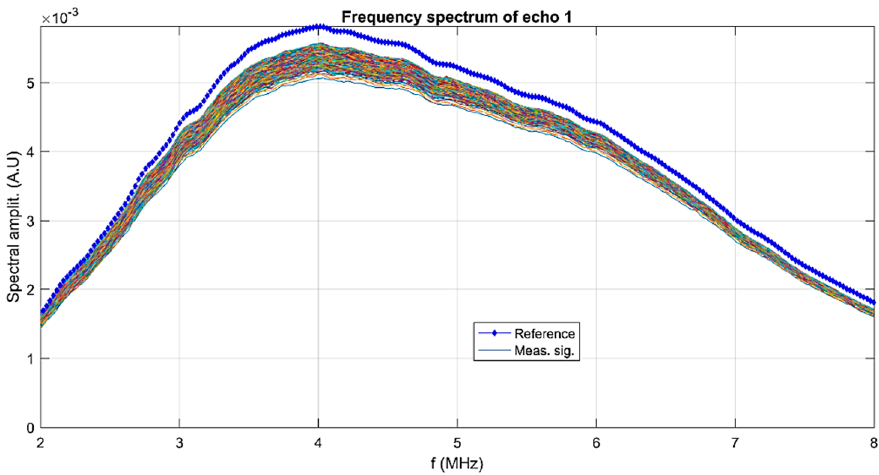
Figure 2. Frequency spectrum of the first transmitted echo. Reference fluid ( ◊ ) and all recorded echoes superimposed (many colors).